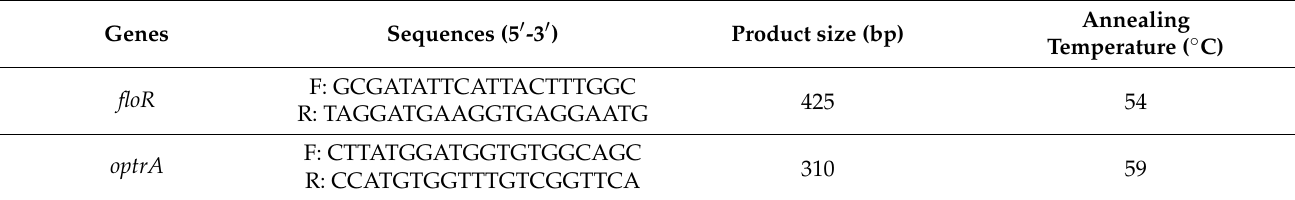
Table 3. Primer information of antibiotic resistance genes (ARGs) for